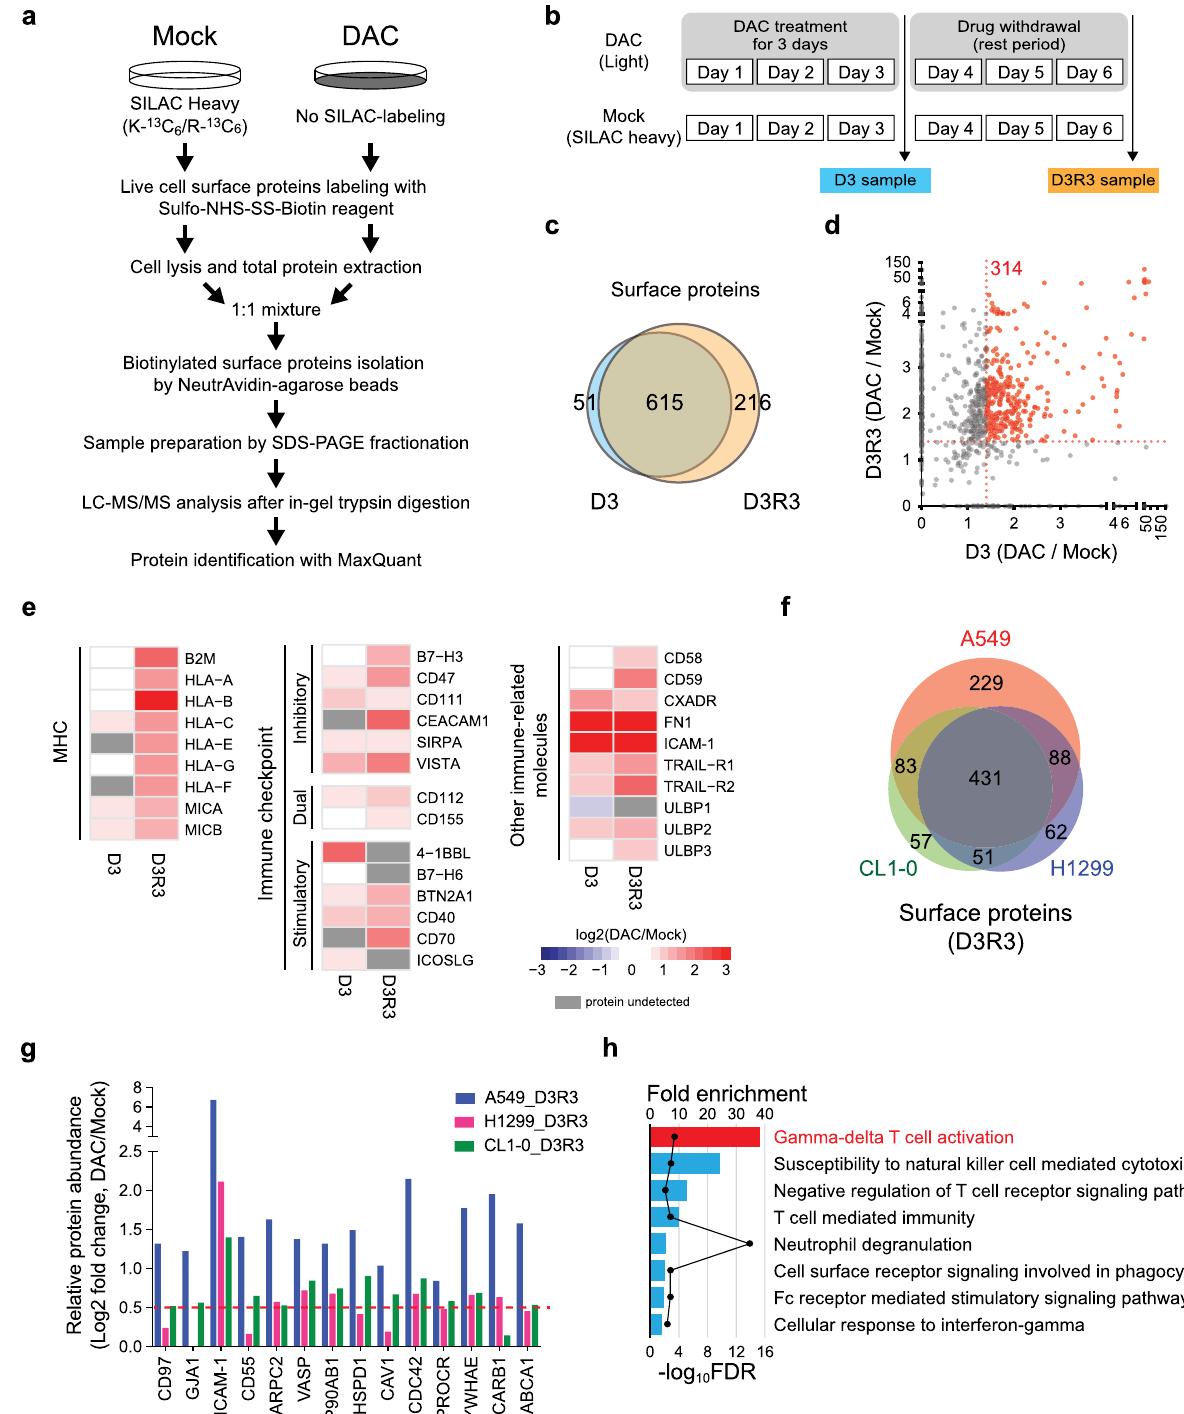
Fig. 1 Decitabine upregulates surface immune molecules related to γδ T cell activation. a Experimental diagram of stable isotope labeling with amino acids in cell culture (SILAC)-based quantitative proteomics on biotinylated surface proteins in mock-treated vs. decitabine (DAC)-treated lung cancer cells. SDS-PAGE sodium dodecyl sulfate polyacrylamide gel electrophoresis, LC-MS/MS liquid chromatography-tandem mass spectrometry. b Treatment schedule of DAC at 100 nM daily for 72 h (D3), followed by drug withdrawal for 3 days (D3R3). c Venn diagram showing the numbers of surface proteins identi fi ed at D3 and D3R3 in A549 cells. d A scatter plot of proteins upregulated at D3 and D3R3 in A549 cells following decitabine treatment. e Heatmap showing log2 fold changes of immune-related surface molecules in DAC-treated vs. mock-treated A549 cells at D3 and D3R3. f Venn diagram showing numbers of surface proteins commonly identi fi ed at D3R3 in A549, H1299, and CL1-0 cells. g Bar graphs showing relative protein abundance of selected surface proteins related to innate immunity in surface proteomes of A549, H1299, and CL1-0 cells following decitabine treatment at D3R3 as compare with mock-treated cells. n = 1 for each treatment of individual cell lines. h PANTHER gene list analysis on immune-related pathways for proteins upregulated by decitabine at D3R3. FDR false discovery